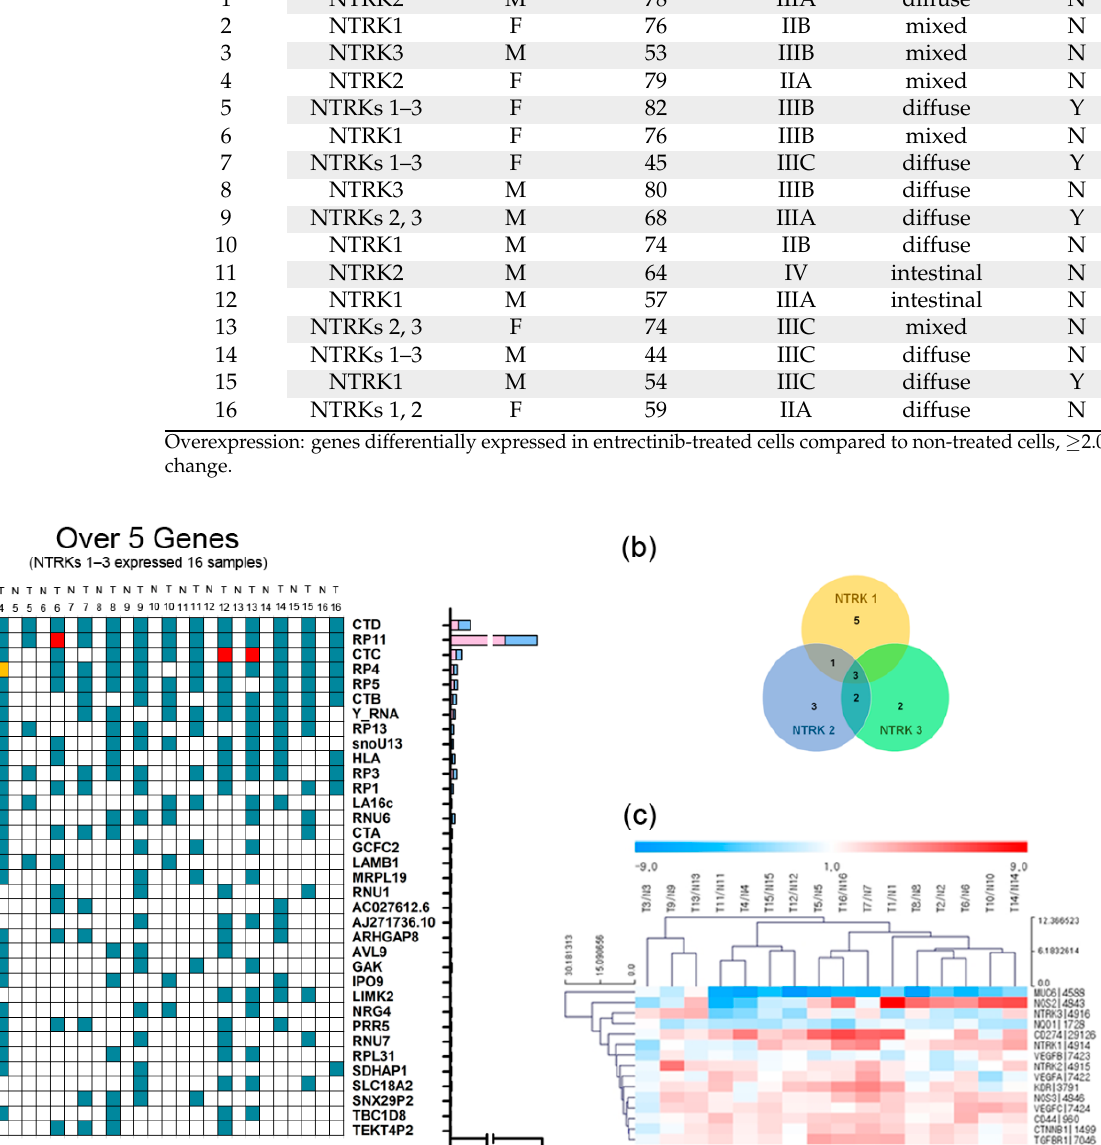
Table 1. The characteristics of patients with NTRK overexpression ( n = 16).